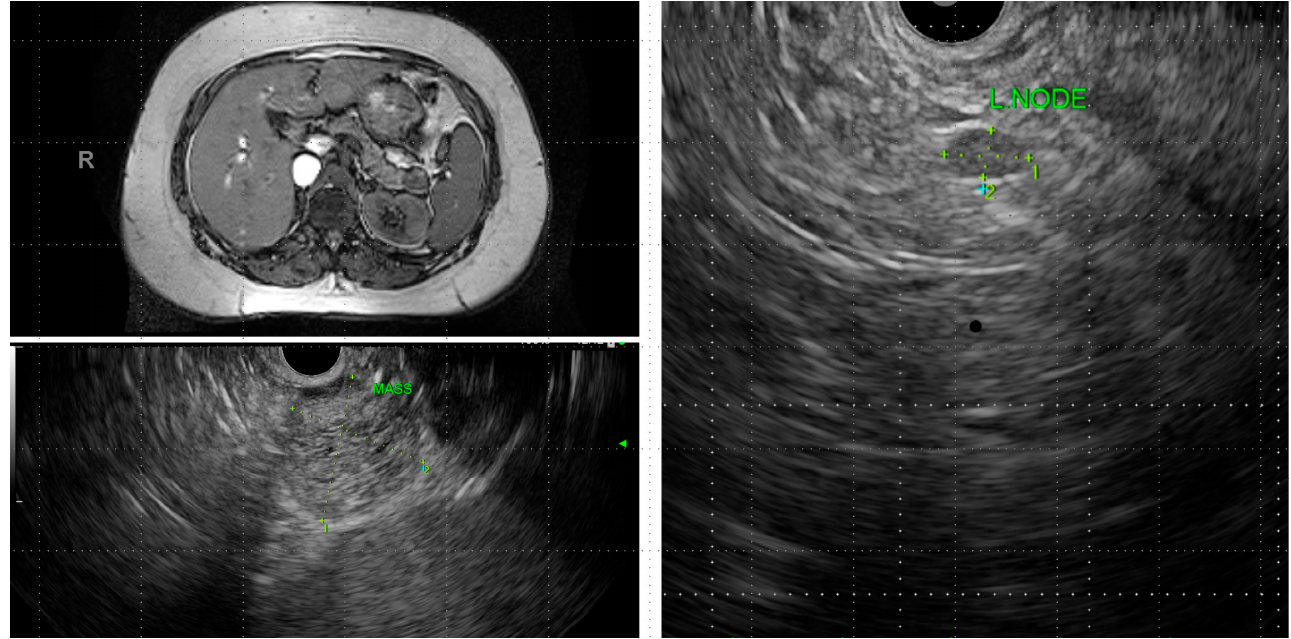
Figure 4. MRI and endoscopic ultrasound demonstrating a solid pseudopapillary neoplasm involving pancreatic tail with a regional lymph node involvement.